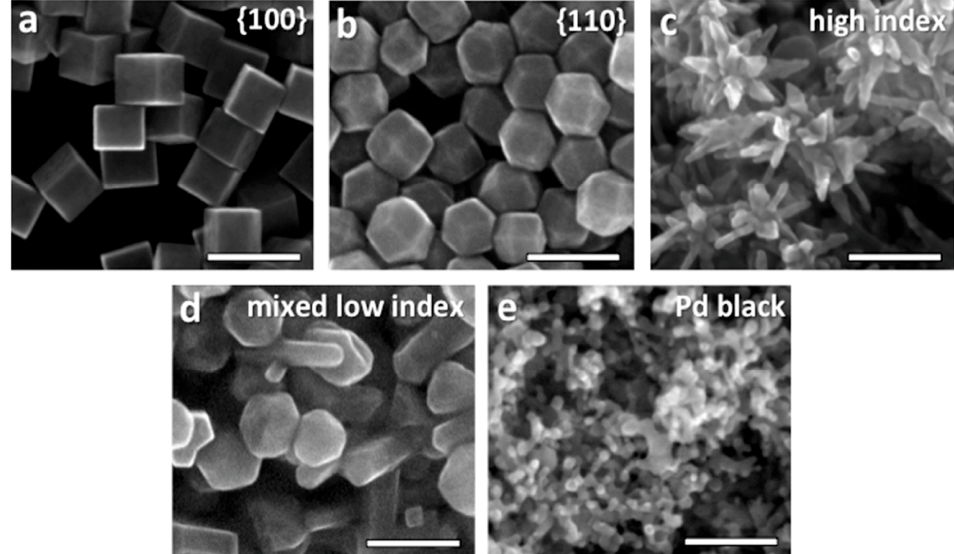
Figure 4. SEM images of Pd NPs used for electrode fabrication: NCs ( a ), RDs ( b ), BNPs ( c ), NPs with mixed low-index facets ( d ), and Pd black ( e ). Scale bar 100 nm. Reprinted (adapted) with permission from [15]. Copyright 2016 American Chemical Society.